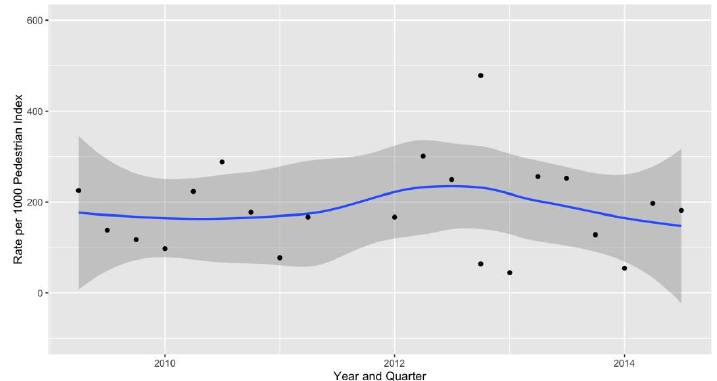
Figure 1. Bicycle Injuries per 1000 Pedestrians Count by Year and Quarter. New York City, Bellevue Hospital Catchment Area, 2008–2014.